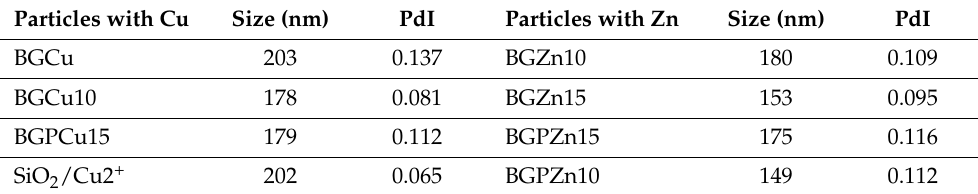
Table 2. Size and PdI parameters obtained by the DLS measurements.